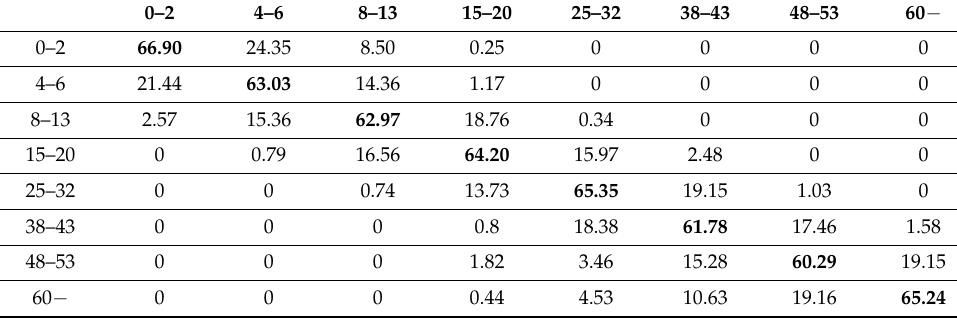
Table 6. Facial age grouping confusion matrix in